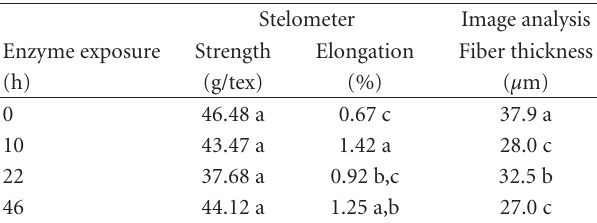
Table 2: Physical properties of enzyme-retted flax fibers ∗